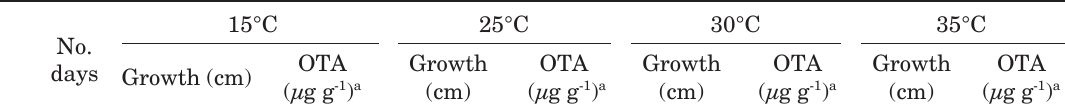
Table 1. Mycelial growth and production of OTA by three A. carbonarius strains on YES (yeast extract sucrose) agar at different temperature